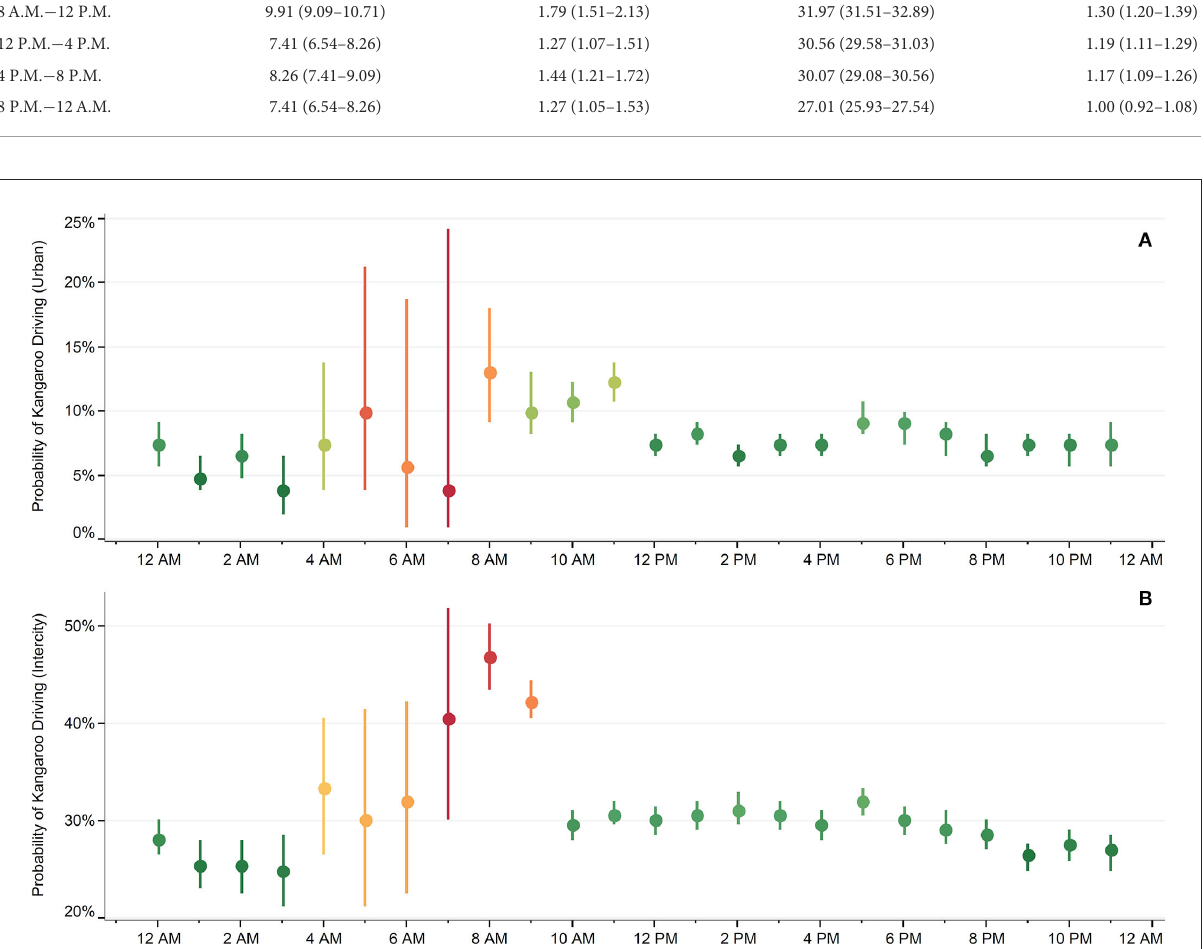
FIGURE1 Probability of kangaroo driving (KD) for urban and intercity trips, by the hour of the day. Probability of KD for urban roads (A) and intercity (B) trips.